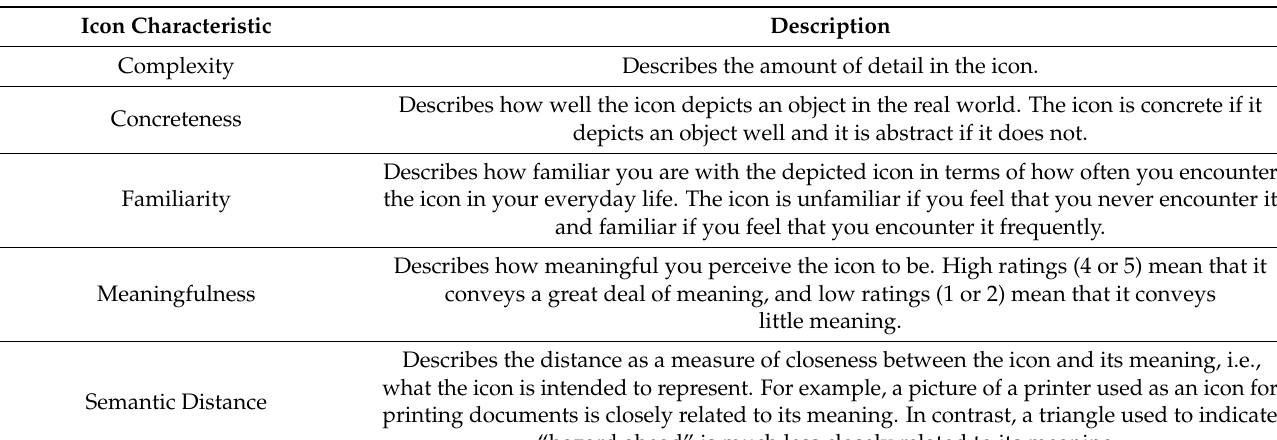
Table 1. Explanations of the icon